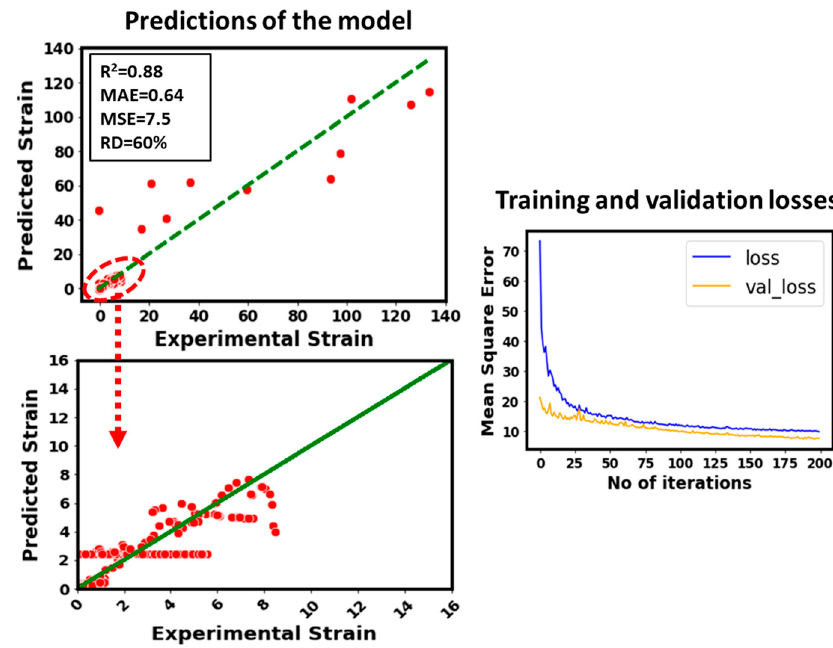
Figure 8. Predictive performance of the developed model by removing unit cell size from the inputs.